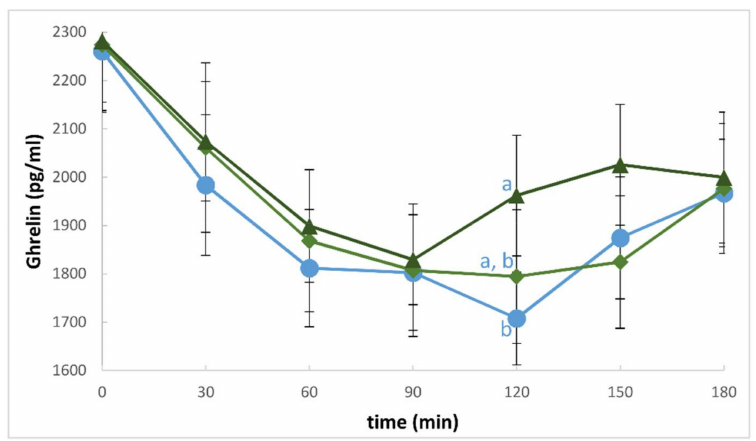
Figure 1. Mean ( ± Standard Error of Mean) postprandial plasma ghrelin concentration in response to the intake of three test meals: Dose 0 Control (D0C), (cid:7) Dose 1 Curry (D1C), (cid:78) Dose 2 Curry (D2C). The differences between the treatments at each time point were measured after controlling for the baseline values. Treatments that were significantly different from each other ( p -value < 0.05) are represented by different letters. At time 120 min, there was a significant main effect of the treatment, although there was only marginal significance observed between Dose 0 and Dose 2 ( p -value = 0.056), as shown in the figure